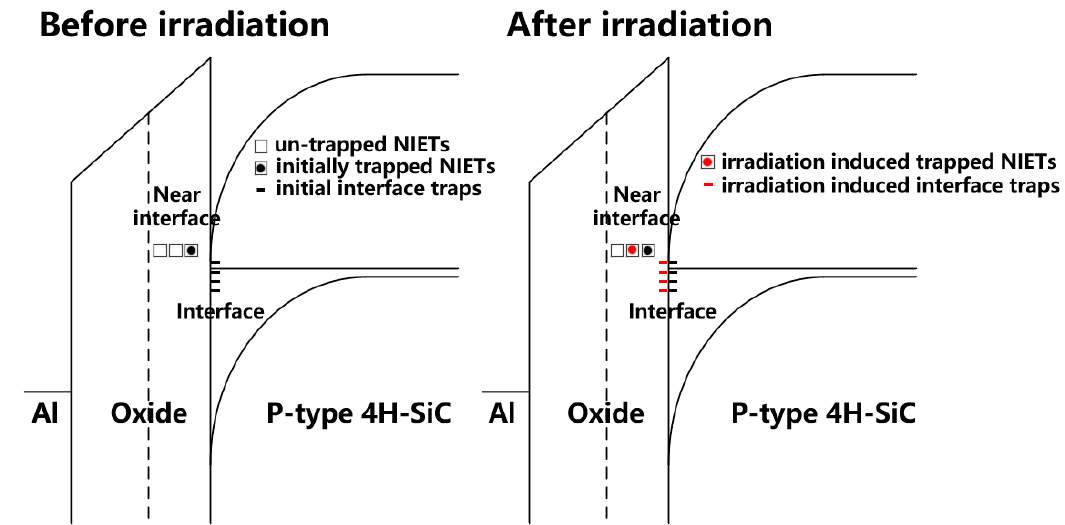
Figure 20. Energy band diagrams for the effect of proton irradiation on NIETs and interface traps.